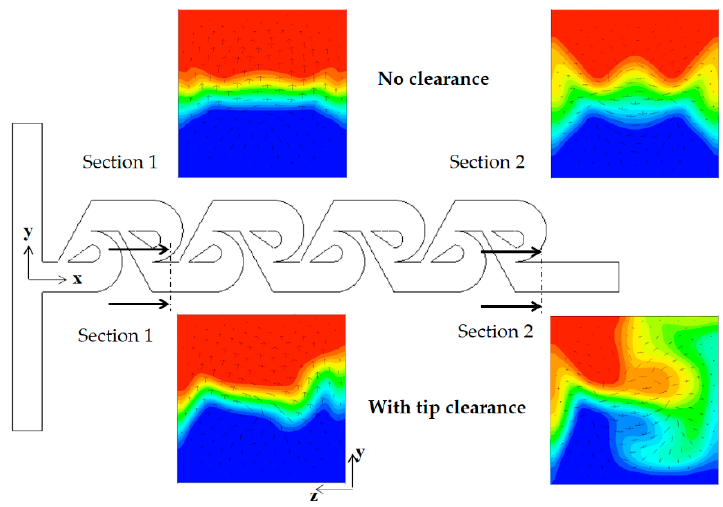
Figure 14. Concentration contours with velocity vector on the yz planes for Re =5.